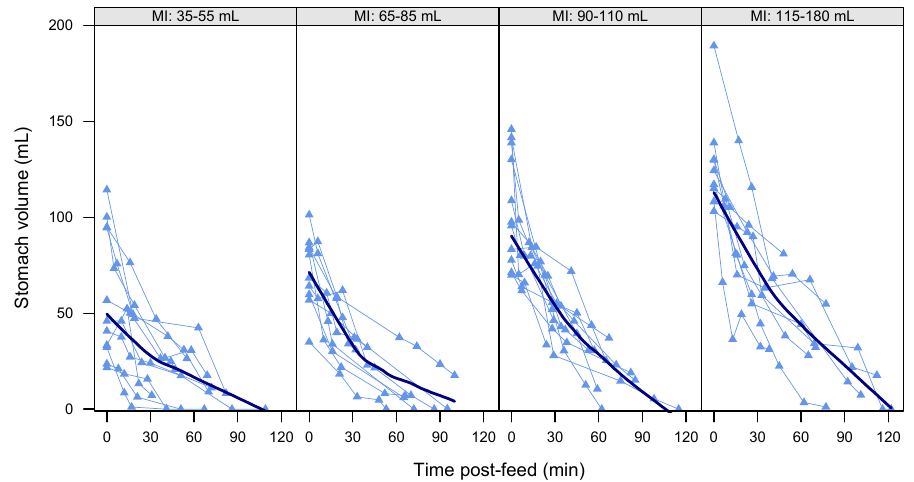
Figure 3. Gastric emptying of individual feeds in term breastfed infants ( n = 41 feeds). Feeds are grouped by milk intake (MI) to illustrate the effect of the feed volumes; approximately equal numbers are included in each panel. Data points represent stomach volumes calculated from ultrasound images; connecting lines link measurements from the same feed. Bold line represents local regression smoother (LOESS, span = 0.9).